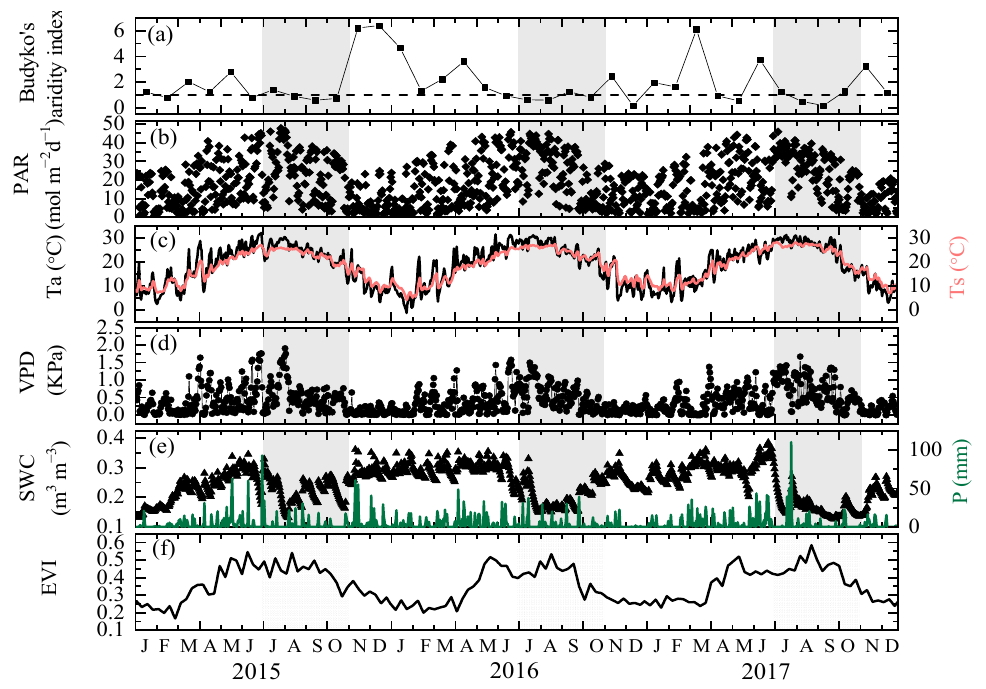
Figure 2. Seasonal variations in monthly ( a ) Budyko’s aridity index (AI), daily ( b ) photosynthetically active radiation at a height of 39.6 m (PAR), ( c ) canopy air temperature at height of 11.6 m (Ta) and soil temperature at a depth of 5 cm (Ts), ( d ) atmospheric vapor pressure deficit (VPD) at height of 11.6 m, ( e ) soil moisture at a depth of 5cm (SWC) and precipitation, and ( f ) the enhanced vegetation index (EVI) between 2015 and 2017. Gray areas represent seasonal drought periods (July − October) based on the AI values.